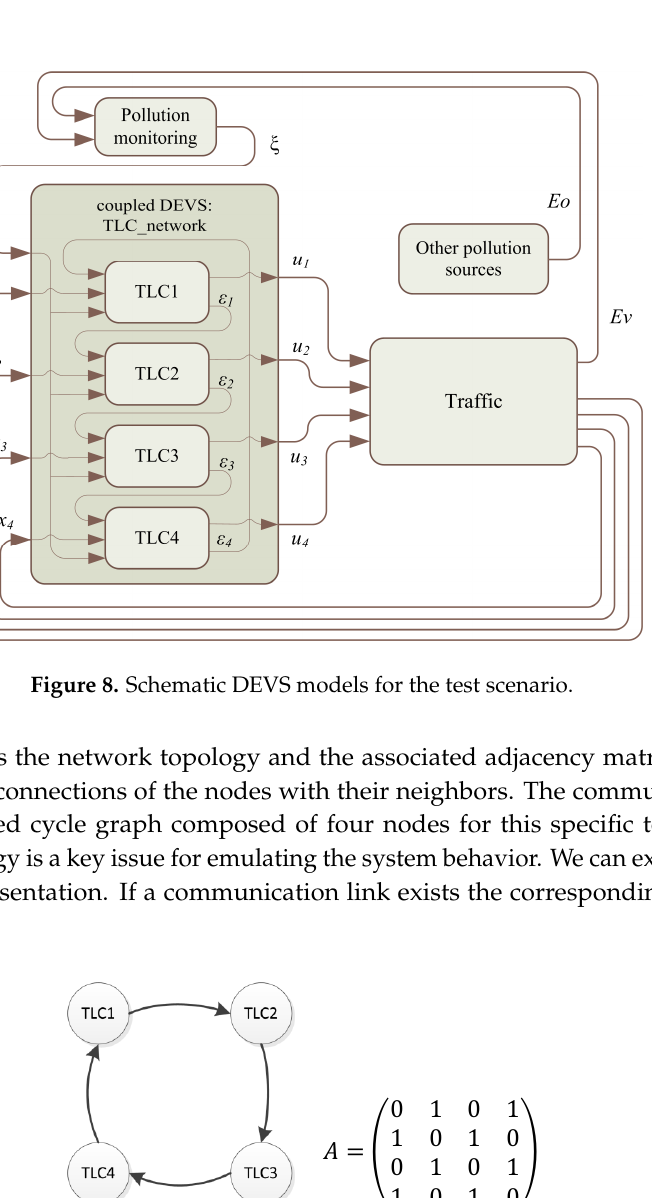
Figure 9. Network communication topology ( a ) and associated adjacency matrix ( b ).